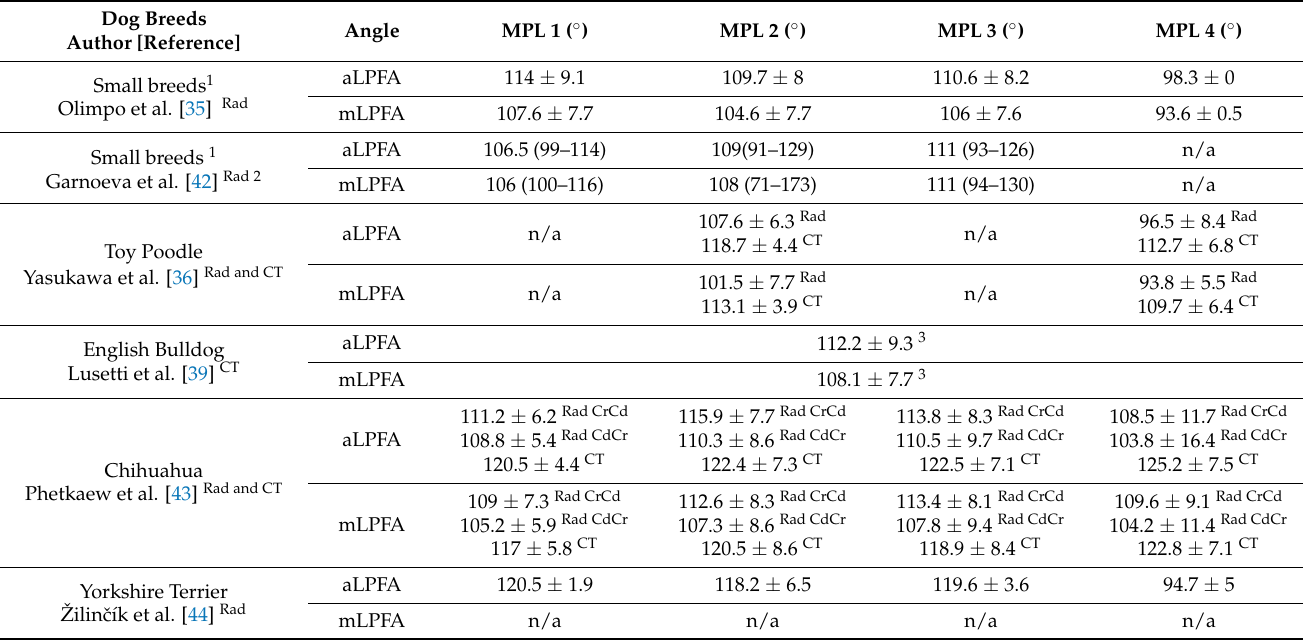
Table 7. Mean ± standard deviation of the anatomical lateral proximal femoral angle and mechanical lateral proximal femoral angle in dogs with different grades of